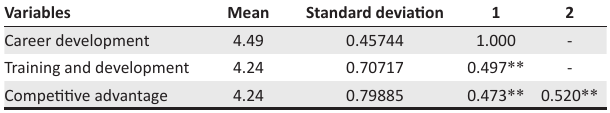
TABLE 4: Descriptive statistics and the correlation matrix. Variables